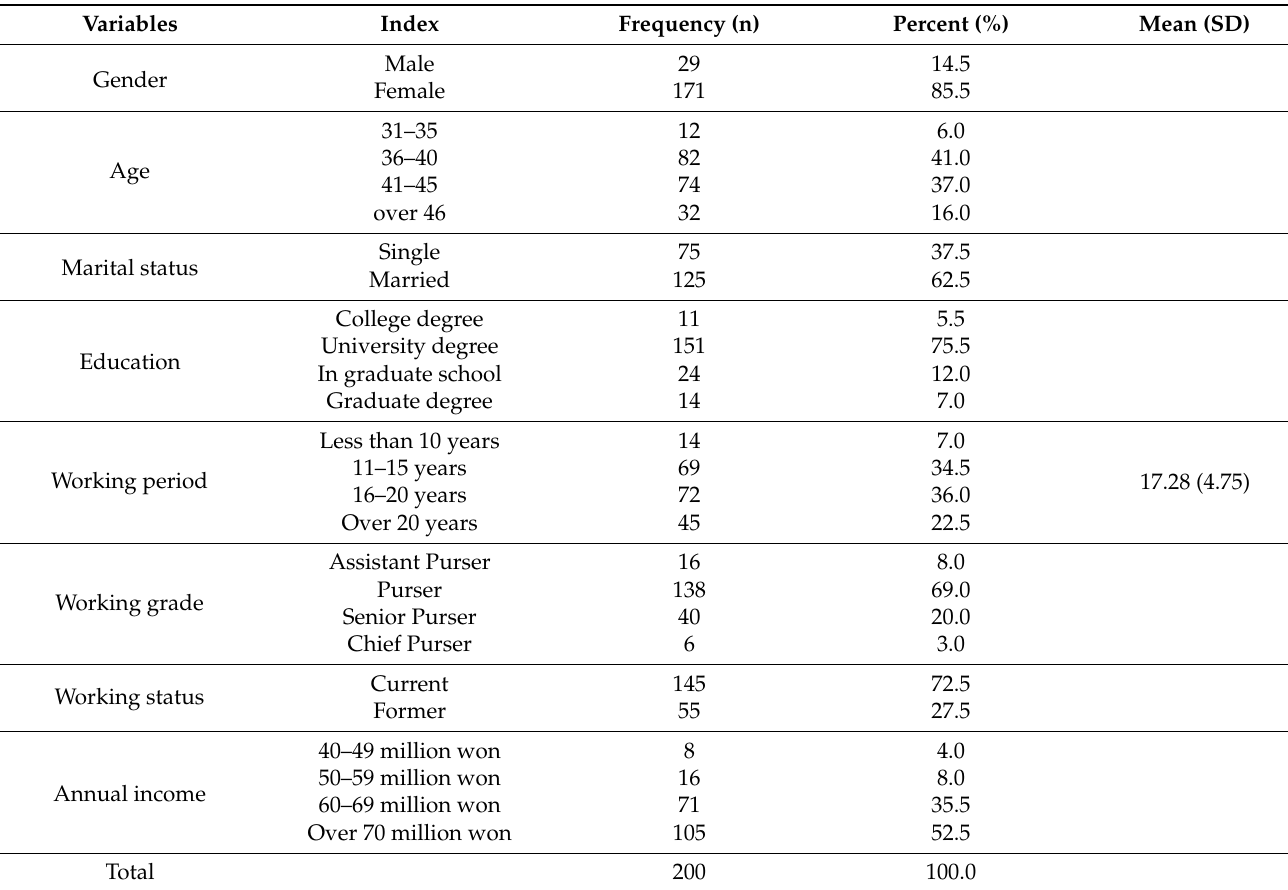
Table 1. Demographic